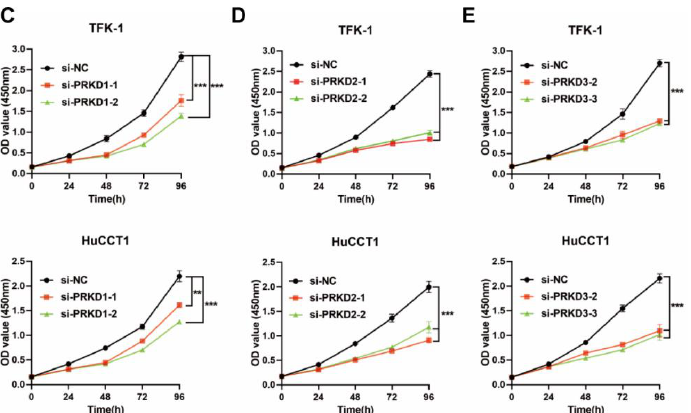
Figure 5. Screening PK candidates with siRNAs: Relative proliferation of ( A ) TFK-1 and ( B ) HuCCT1 cells, transfected siRNA for each PK candidate, were measured by CCK-8 assay. Proliferation of TFK-1 and HuCCT1 cells treated with siRNAs for ( C ) PRKD1, ( D ) PRKD2, or ( E ) PRKD3 was measured by using the CCK-8 assay. * p < 0.05, ** p < 0.01, *** p < 0.001, p -value was determined by two-way ANOVA. Data are presented with means ± SDs and from three independent experiments.